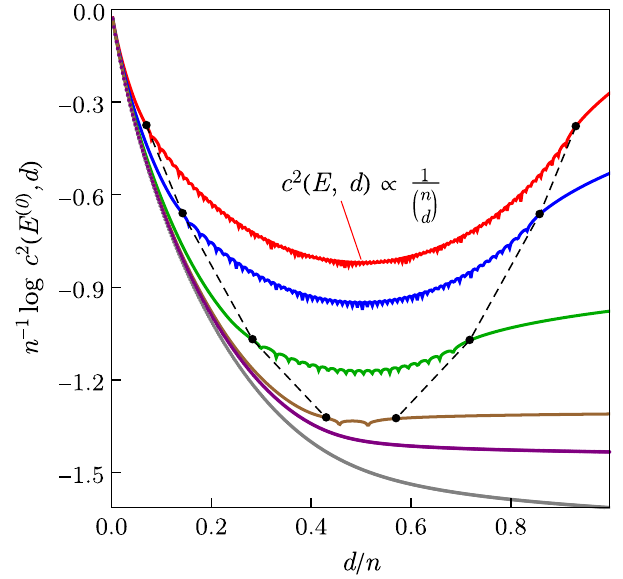
FIG. 2. Colored lines show the dependence of the rescaled logarithm of the coupling coefficient n − 1 log c 2 ð E; d Þ [Eq. (23)] on the rescaled Hamming distance d=n for n ¼ 400 . The energy E is set to the value E ð 0 Þ ≃ − n − B 2 ⊥ that reflects the overall shift of the impurity band due to the transverse field [cf. Eqs. (36) and (37)]. Different colors correspond to different values of the transverse field B ⊥ ¼ 1 . 93 (red), 1.43 (blue), 1.11 (green), 1.01 (brown), 0.99 (purple), and 0.95 (gray). The scale along the y axis suggests that c ð E ð 0 Þ ; d Þ scales exponentially with n for d=n ¼ O ð n 0 Þ . The inset shows the leading-order factor in the d dependence of the coupling coefficient for B ⊥ > j E j =n [cf. Eq. (33)]. Black dots show the boundaries d ¼ n= 2 − m 0 ; n= 2 þ m 0 of the region of the oscillatory behavior of c ð E; d Þ with d given by the WKB theory [Eq. (32)] (see Appendix B for